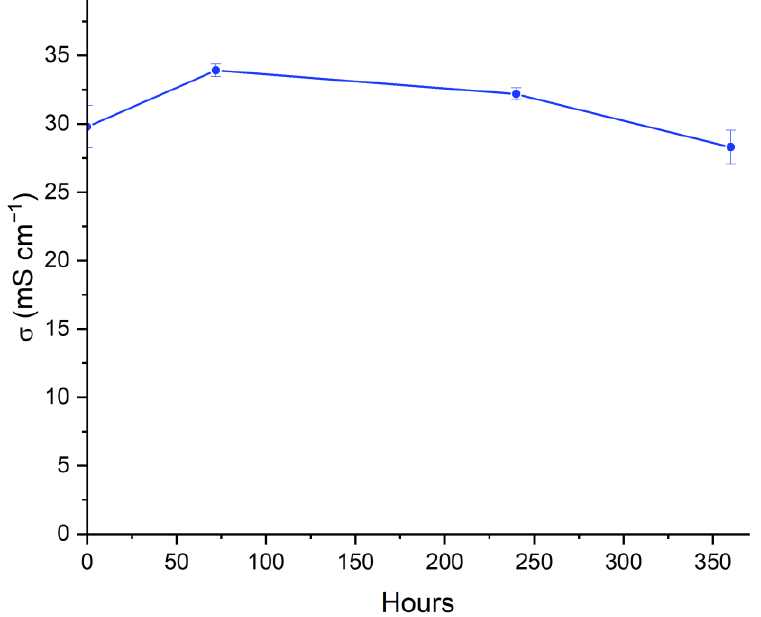
Figure 11. The alkaline stability of eQP-PDD 0.5 AEMs.